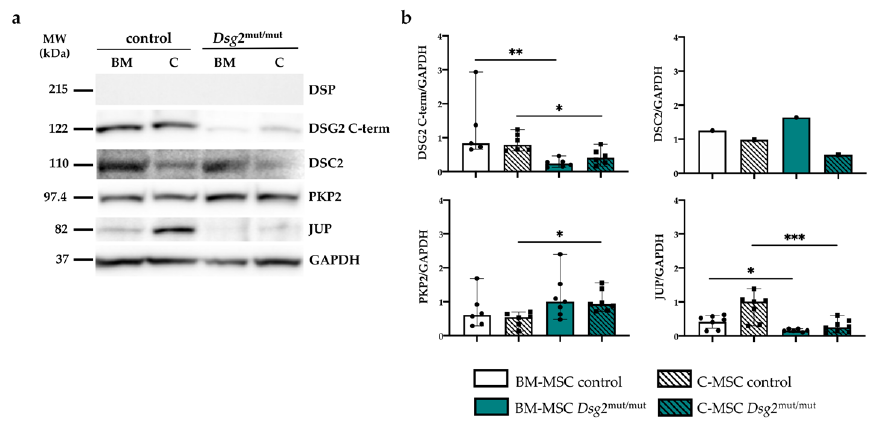
Figure 1. Cardiac and bone marrow mesenchymal stromal cells express desmosomal proteins, whose profile changes in the AC background. ( a ) Western blotting on protein extracts from cultured cardiac- and BM-MSCs, isolated from either control or Dsg2 mut/mut adult male mice. GAPDH was used to ensure equal protein loading. MW, molecular weight. DSP, desmoplakin; DSG2, desmoglein-2; DSC2, desmocollin-2; PKP2, plakophilin-2; JUP, plakoglobin. ( b ) Densitometric analyses of the WB in ( a ). A total of 4 samples for each group were analyzed. Three independent experiments were performed, with the exception of DSC2. In the graph of JUP, bars represent mean, and error bars represent the relative standard deviation (SD). In the others, bars represent median, and error bars represent the limits of 95% confidence interval (CI). * p ≤ 0.05; ** p ≤ 0.01; *** p ≤